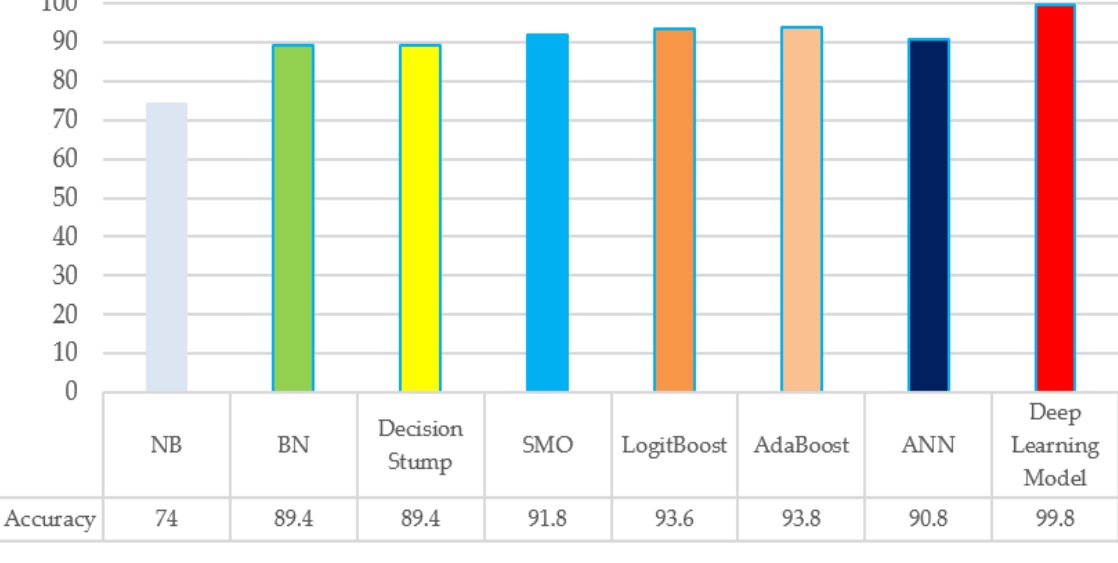
malicious executable.